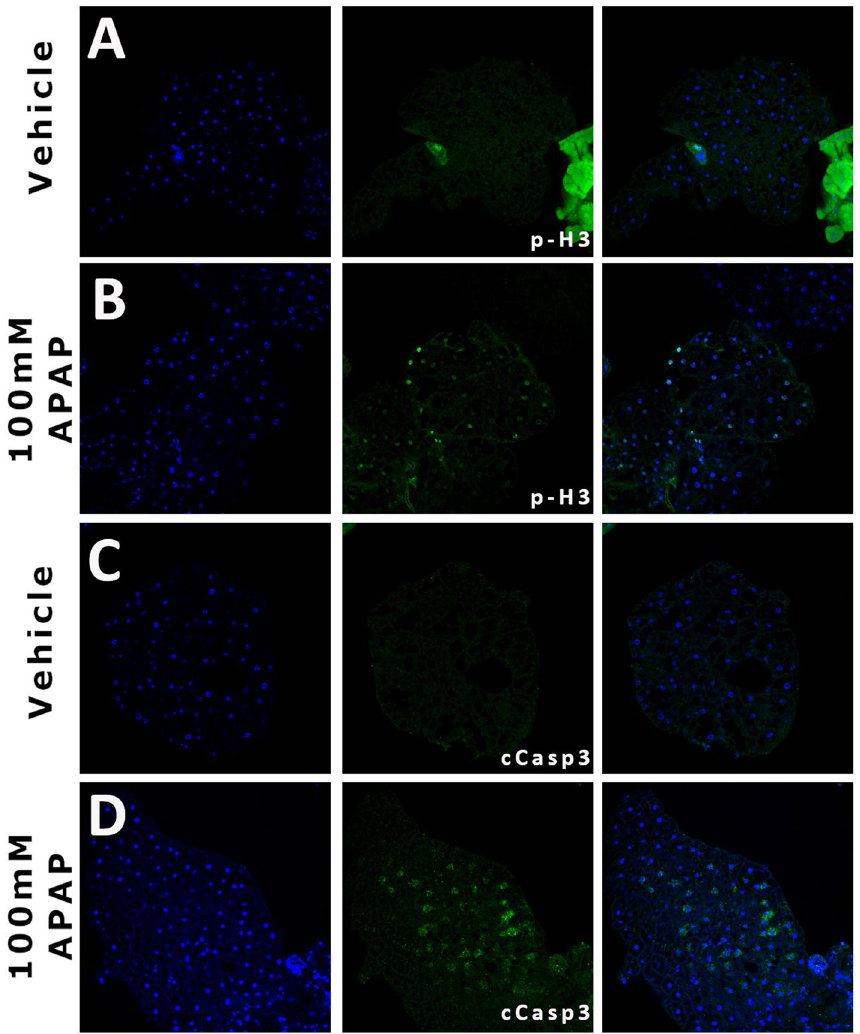
Figure 3. APAP exposure induces regenerative and apoptotic responses in the adult fat body. Representative images of adult Drosophila fat bodies from vehicle-treated ( A and C ) and 100 mM-treated ( B and D ) animals stained for p-H3 ( A and B ) and cCasp3 ( C and D ). APAP and/or vehicle exposure was 4 days. p-H3 = phosophorylated Histone 3; cCasp3 = cleaved caspase